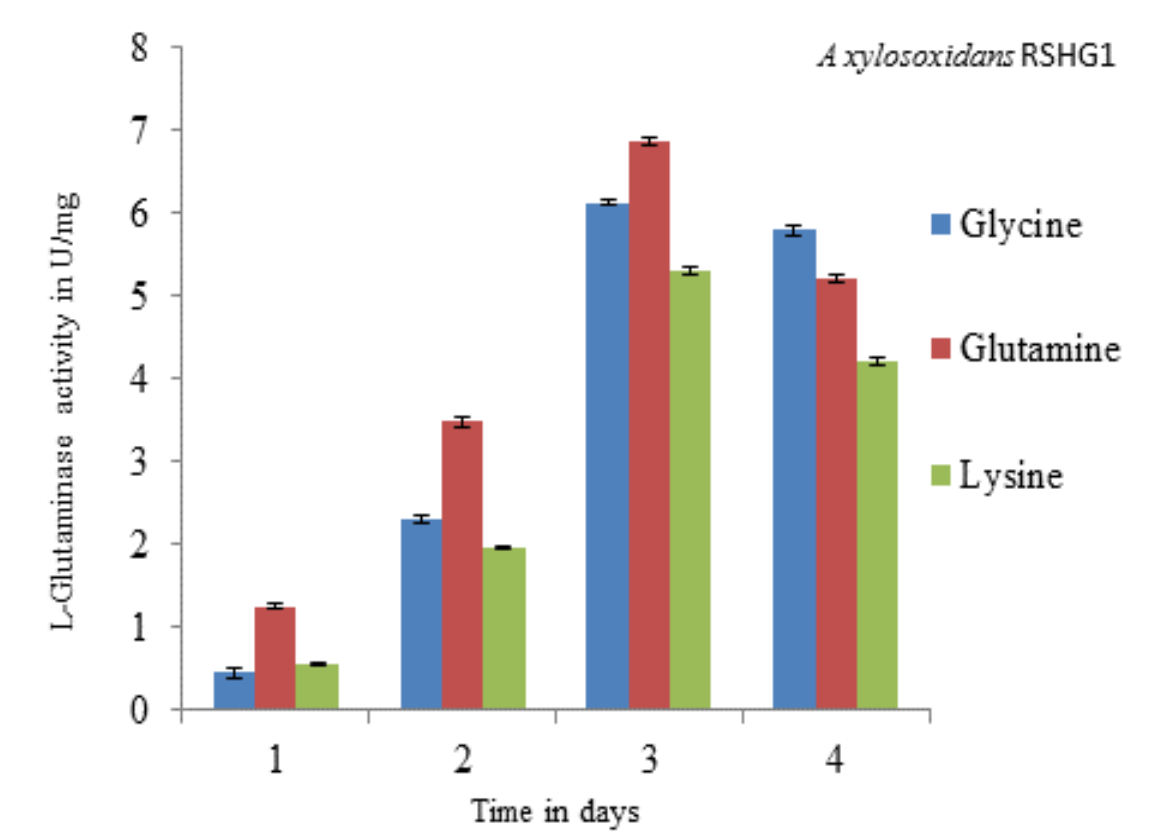
Figure 7. Effect of nitrogen sources on Glutaminase production by A. xylosoxidans on fermentation medium at 30 °C, pH 9.